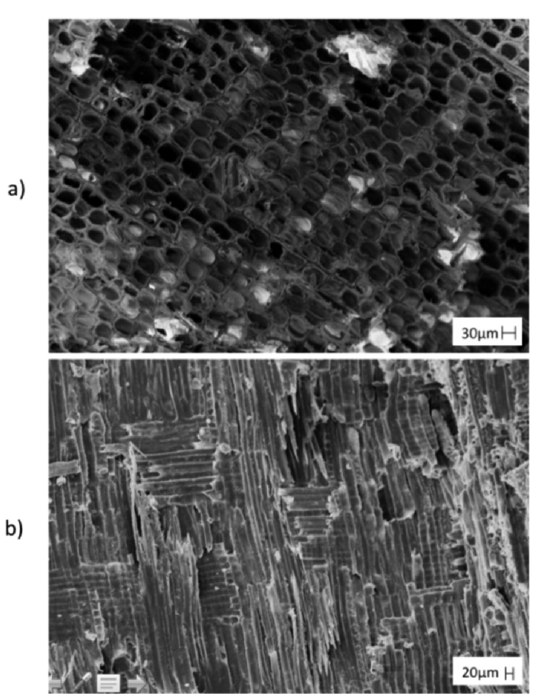
Figure 11. SEM images from a) Pinus taeda and b) Dinizia excelsa Ducke